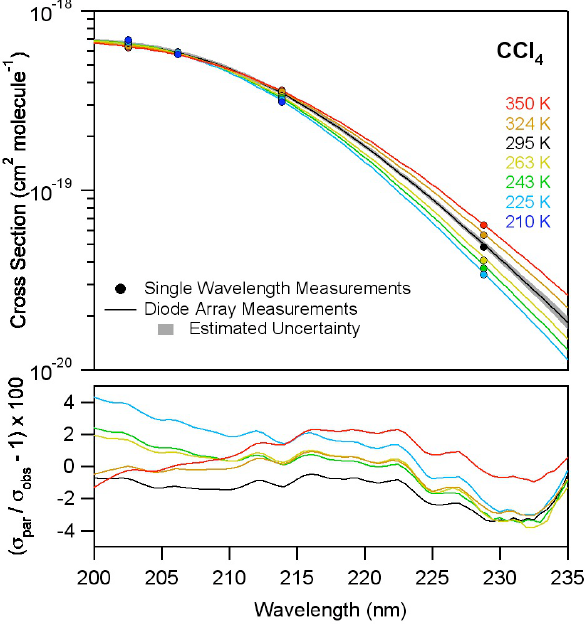
Fig. 4. Absorption spectra of CCl 4 obtained using a diode array spectrometer (solid lines) at temperatures given in the legend. The shaded region represents the estimated absolute 2 σ (95% confi- dence level) uncertainty at 295K including estimated systematic er- rors. Also included for comparison are the absorption cross sections obtained from the single wavelength measurements in this work ( • ). The deviation of the measured spectra from the cross section param- eterization given in Table 3 is given in the lower frame.